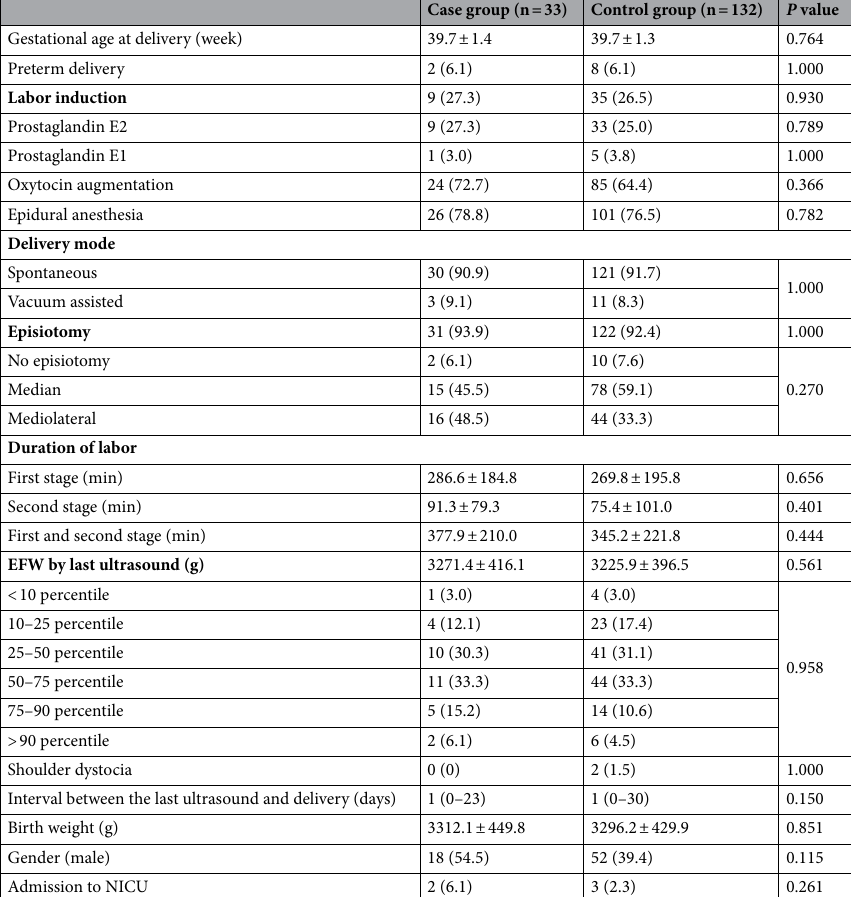
Table 2. Delivery outcomes. Data expressed as mean ± standard deviation, median (range) or number (%). EFW estimated fetal weight, NICU neonatal intensive care unit.